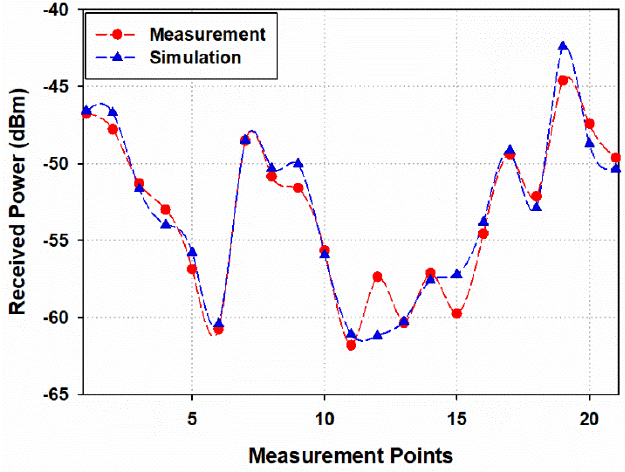
Figure 17. Received power measurements vs 3D ray-launching(3D- RL) simulation comparison.